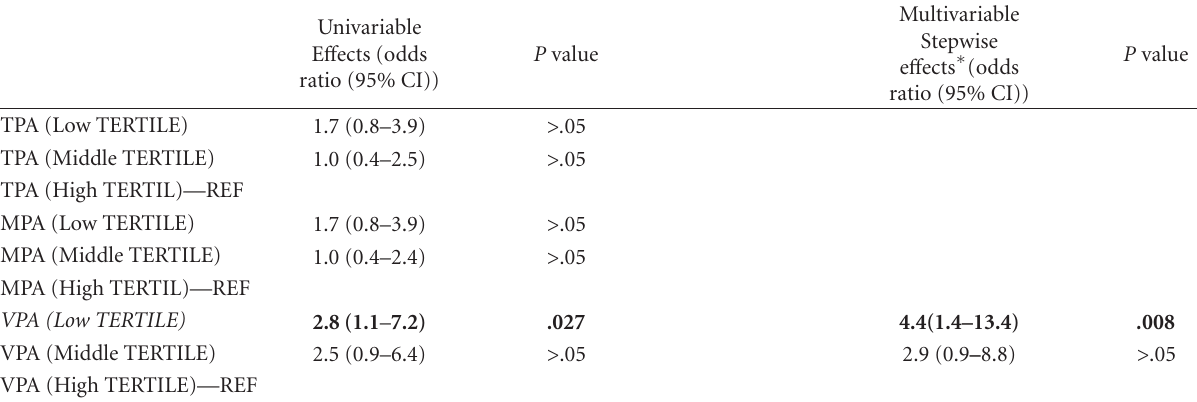
Table 2: Univariable and multivariable logistic